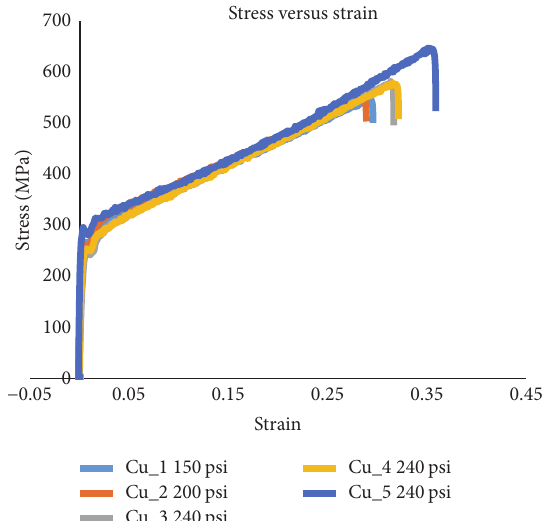
Table 2: Material properties and model constants for Al. Material